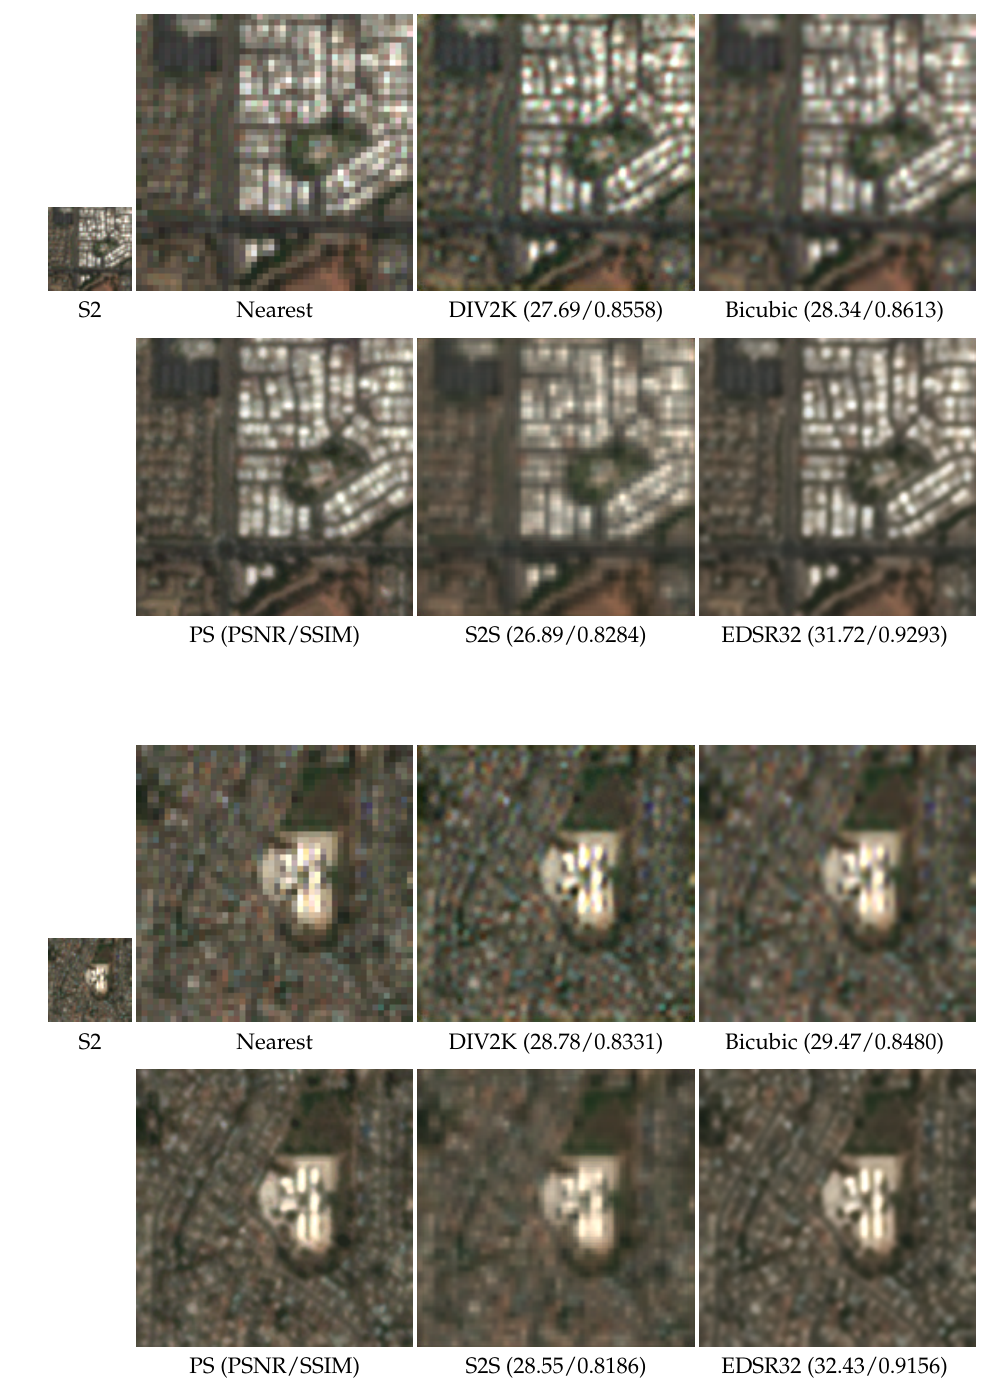
Figure A1. Visual comparison (RGB) of the baseline and EDSR32 models (tiles from test